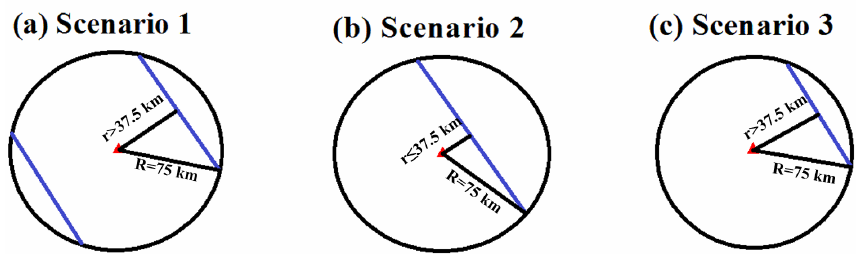
Figure 5. Schematic diagrams showing the location of CALIOP ground tracks relative to radiosonde sites according to (a) scenario 1 (with two CALIOP ground tracks, the shortest distance to each of which is more than 37.5km from radiosonde site); (b) scenario 2 (with one CALIOP ground track, the shortest distance to which is less than 37.5km from the radiosonde site); and (c) scenario 3 (with one CALIOP ground track, the shortest distance to which is more than 37.5km from radiosonde site) showing the geometric relationship of CALIOP ground tracks relative to radiosonde sites. A circle with a radius of 75km centered at radiosonde sites was chosen to obtain averaged PBLH from CALIOP, as compared with the measured PBLH from ground-based